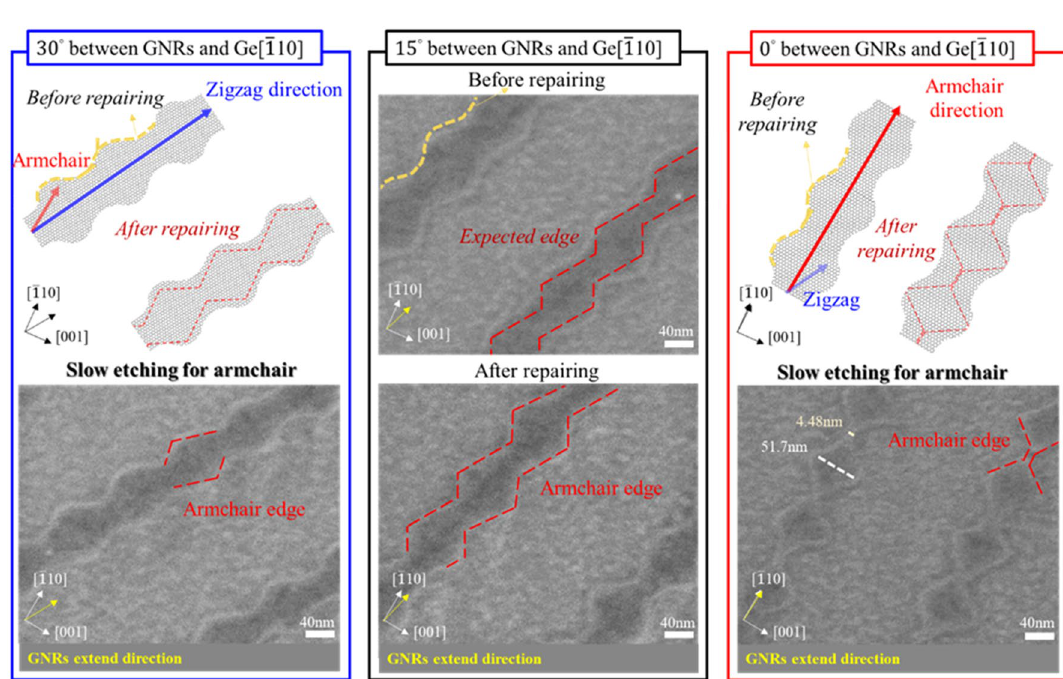
Figure 5. The schematic diagram and SEM images of the CoveGNRs along with along with different directions 0°, 15°, and 30° with respect to Ge[ 110